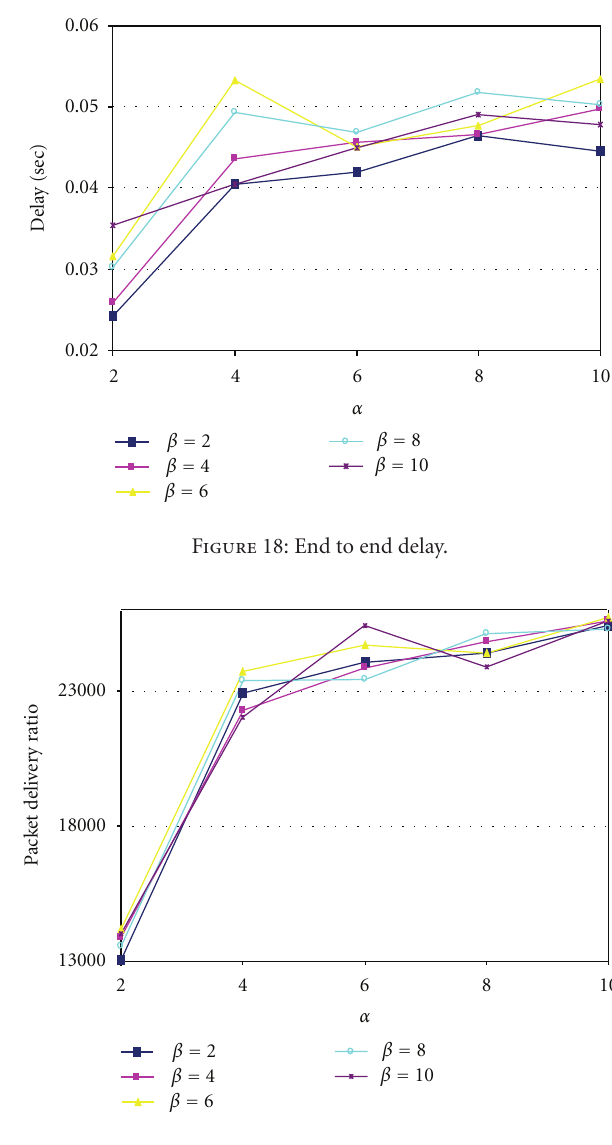
Figure 19: Number of received